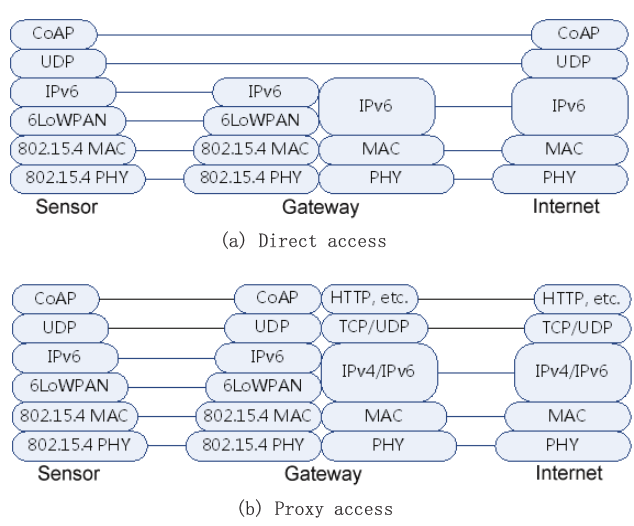
Figure 3. Direct access vs. Proxy